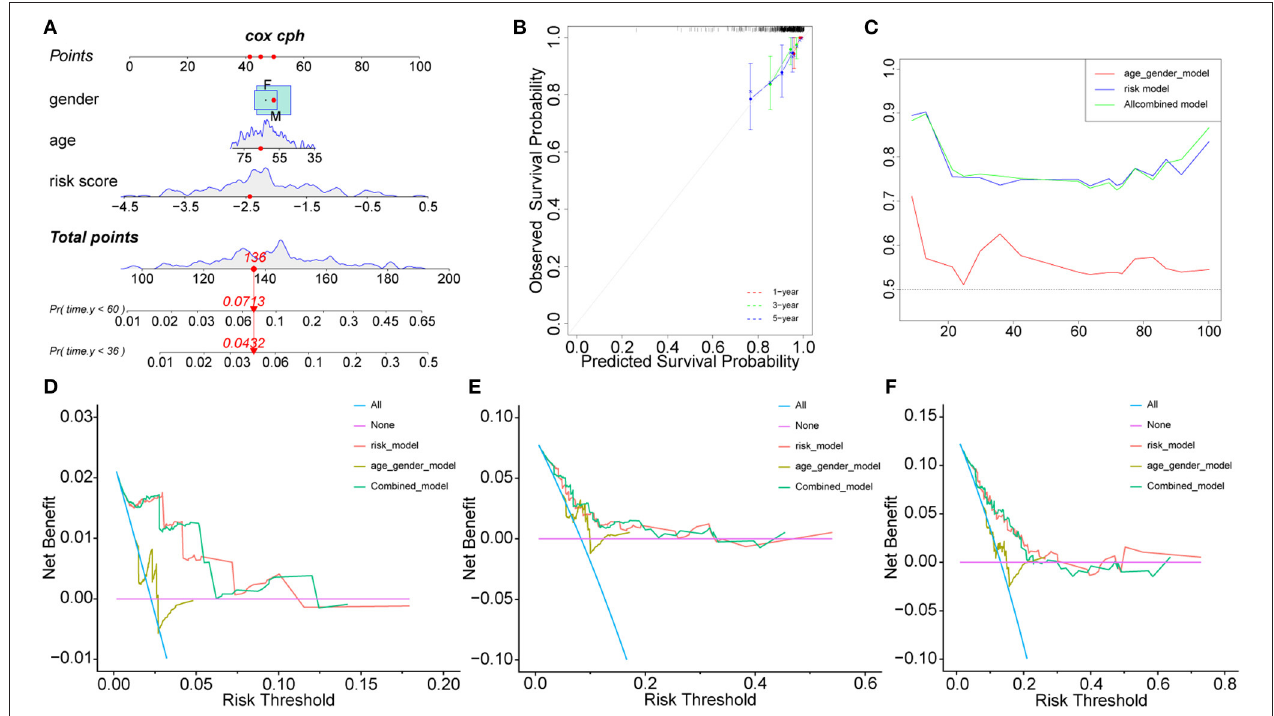
FIGURE 2 | Nomogram model construction in GEO cohort. The development of a nomogram to predict the 3-, and 5-year OS (A) and the corresponding calibration (B) . (C) Area under the curve of time-dependent receiver operating characteristic (ROC) curves. (D–F) Decision curve analyses of the nomograms based on OS for 1-, 3-, and 5-year risk. OS, overall